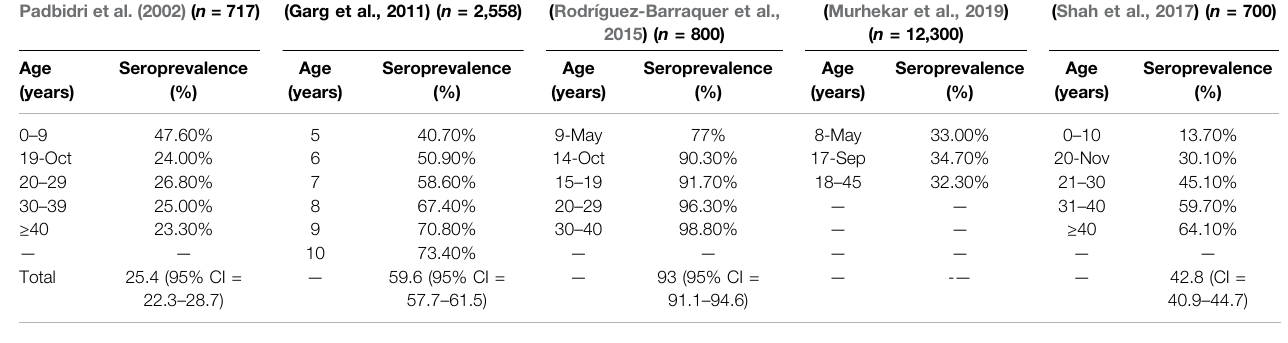
TABLE 1 | Dengue seroprevalence by age, reported in some studies from India.